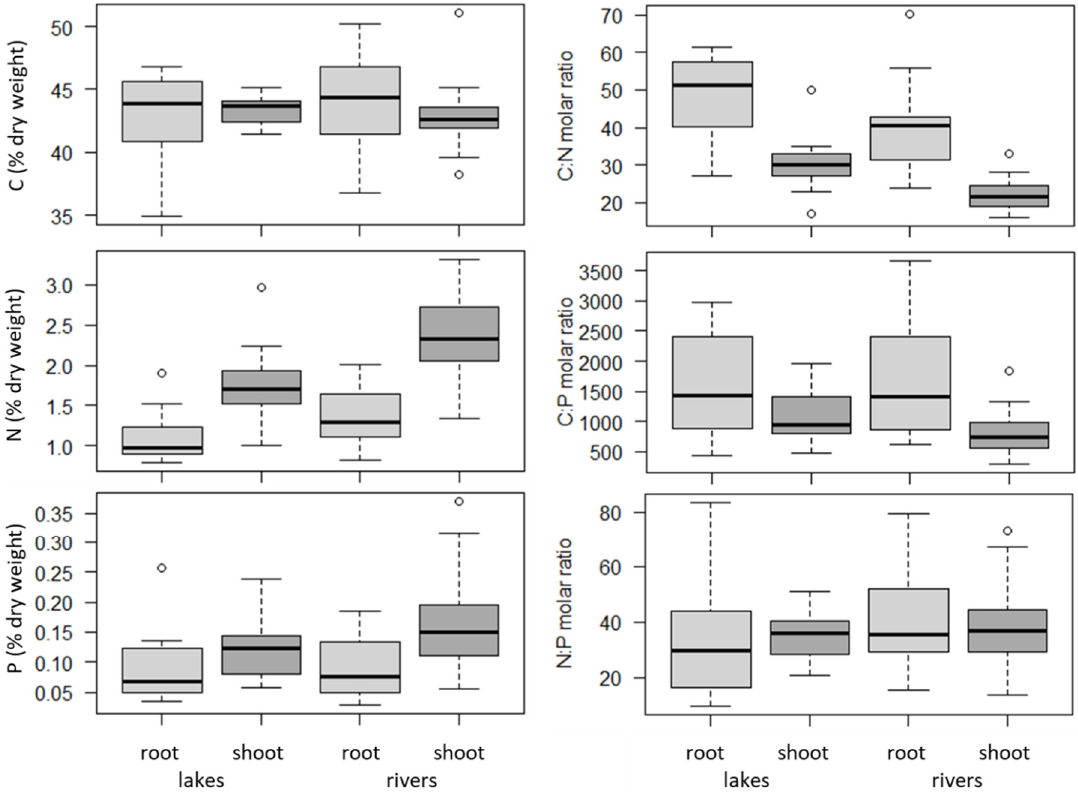
Figure 1. Differences in the element concentrations and stoichiometry of Juncus bulbosus between organs (roots and shoots) and habitats (lakes and rivers)—summer 2010 (Table 4). Table 4. Juncus bulbosus C, N, P tissue concentrations from southern Norway. n = number of Table 3. Percentage of variance in plant nutrient concentrations (C, N, P) and stoichiometry (C:N:P) explained by organs (root versus shoot), habitats (lake versus river) and environmental variables (water and sediment chemistry) using redundancy analyses: singly and after stepwise selection. Only significant explanatory variables are shown. n = 80, missing data were replaced by averages across all samples. TP = total P, EC = electric conductivity.